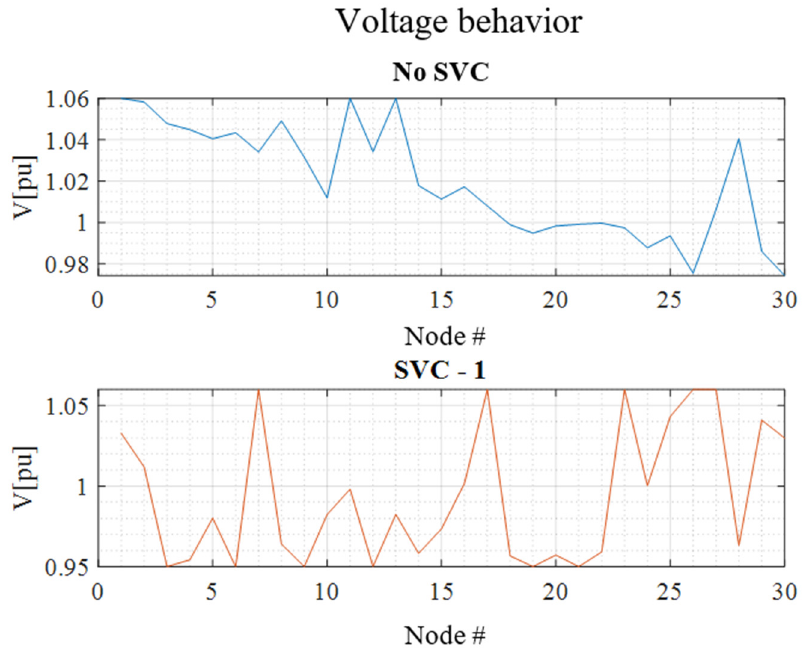
Figure 14. Voltage profile in the IEEE 30-bus test system.